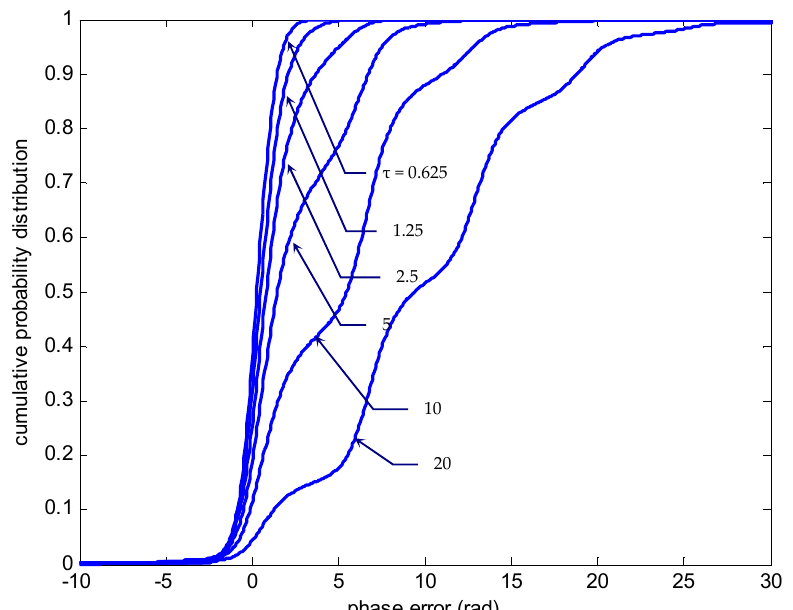
Figure 6. The time-evolution of the nonmodulo-2 π cumulative probability distribution of the phase error for SNR α = 1 ( γ = sin ( π /4 ) ).